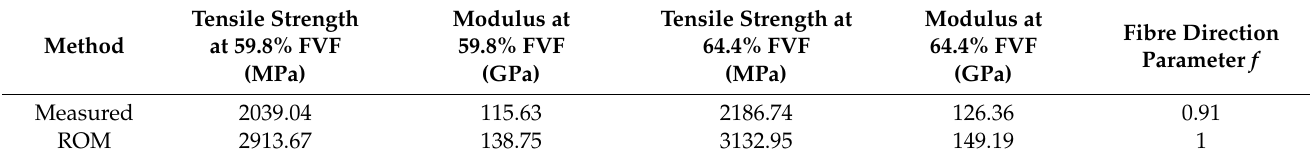
Table 3. Comparison of measured tensile properties with theoretical